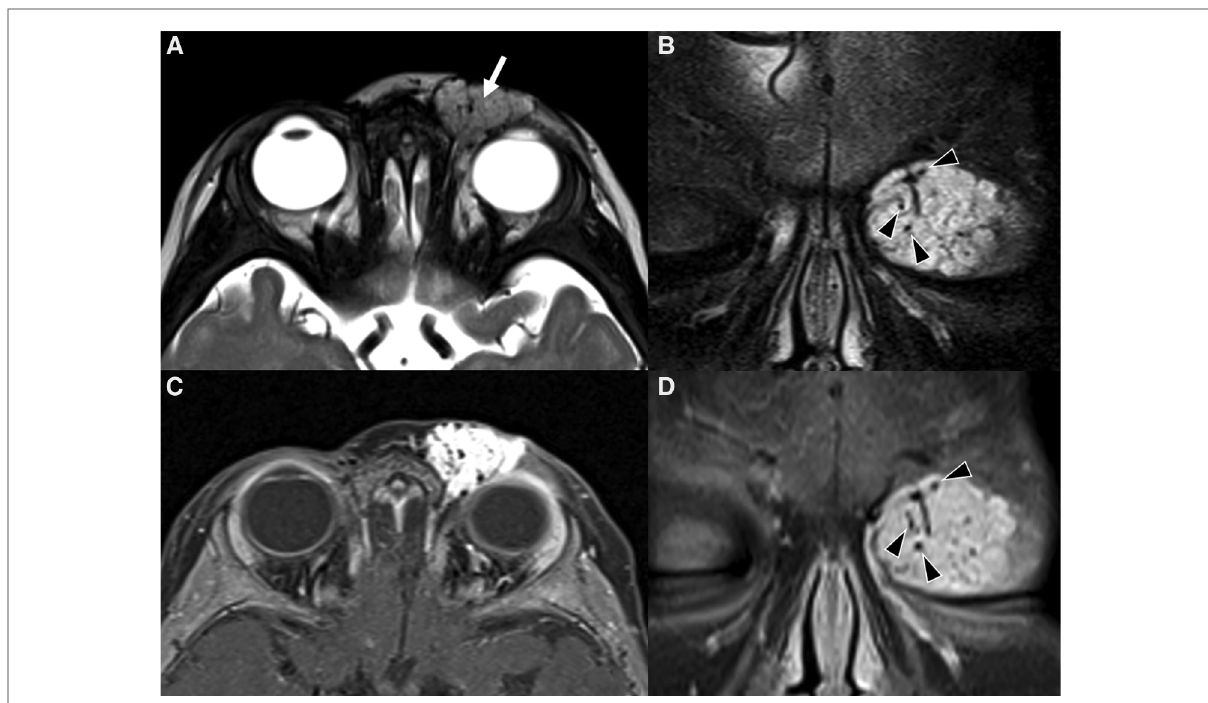
FIGURE 4 Mr images of a non-syndromic left periorbital infantile hemangioma in a 1-year-old girl. Axial ( A ) and coronal fat-saturated ( B ) T2 weight images show a well-de fi ned hyperintense mass (arrow in A ) with multiple internal fl ow voids (black arrowheads in B and D ), extending from the anterior periorbital soft tissues into the extra and intraconal compartments of the orbit. Axial ( C ) and coronal ( D ) contrast-enhanced fat-saturated T1 weighted images show vivid homogeneous contrast enhancement of the vascular